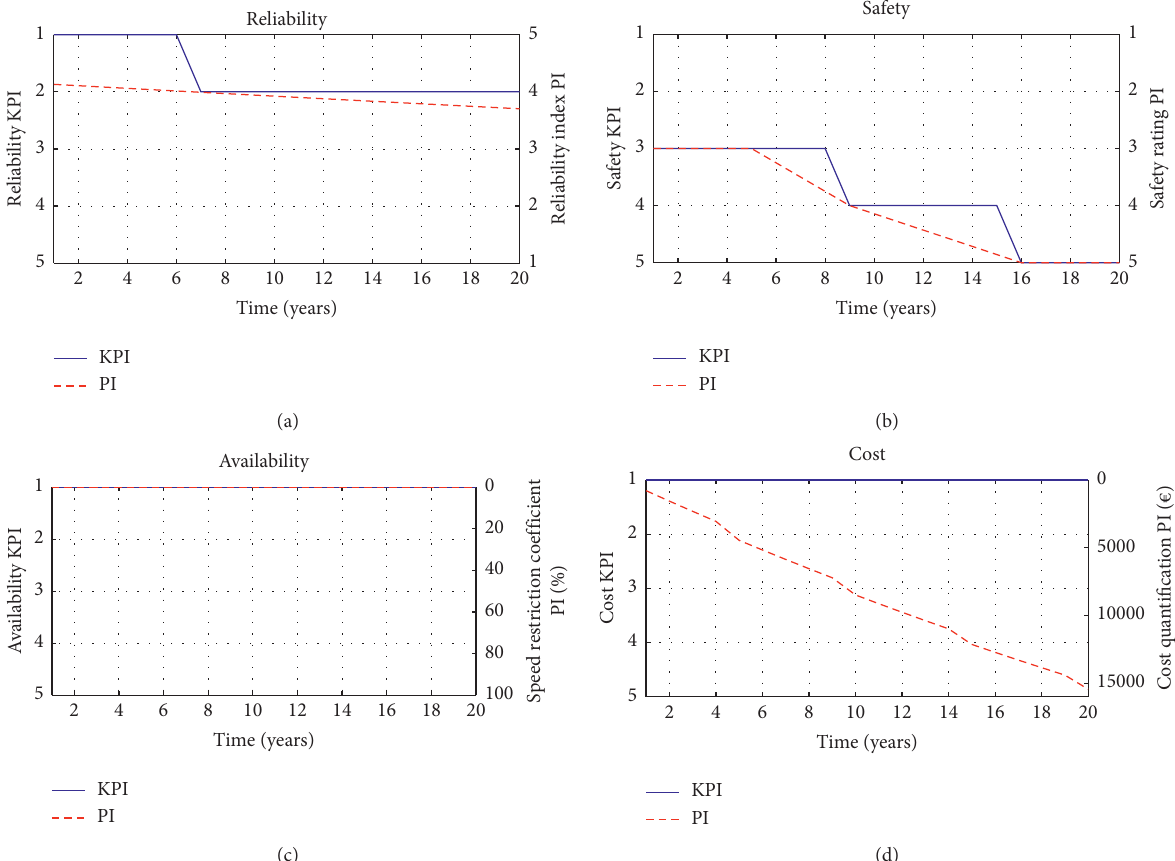
Figure 8: Bridge performance condition considering natural scenario: (a) reliability; (b) safety; (c) availability; (d)